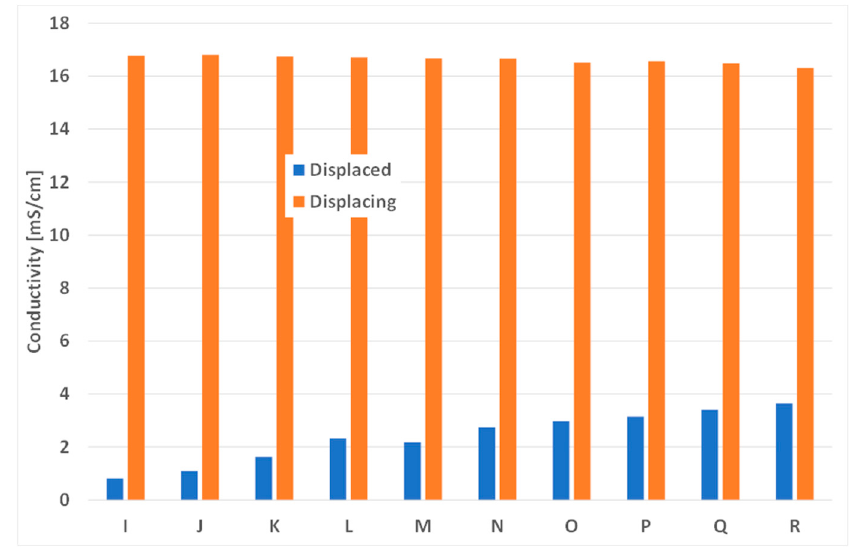
Figure 9. Fluid conductivity measured during 10 consecutive displacement experiments using the conductivity probe C0.